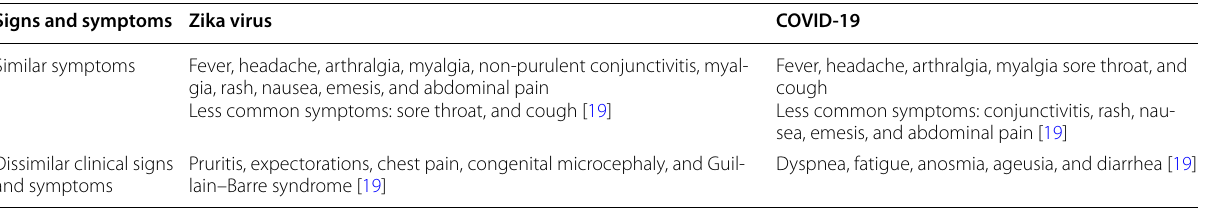
Table 1 The clinical correlation of both Zika Virus and COVID‑19 Signs and symptoms Zika